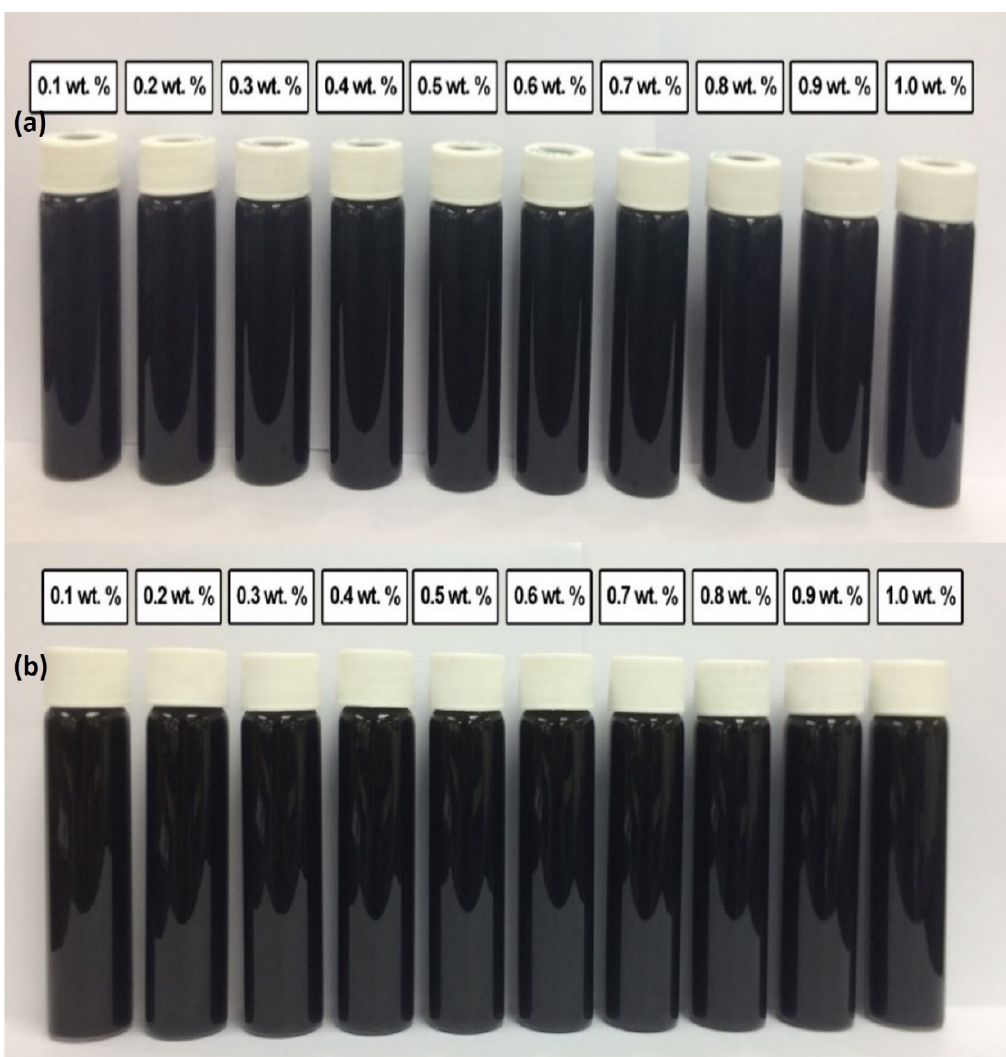
Figure 7. Stability and dispersion condition of various weight percentage of the surface oxidized MWCNTs (MWCNT-MB) based nanofluid without surfactant for ( a ) 0.5 h; ( b ) 100 h after homoge- nization and sonication process.